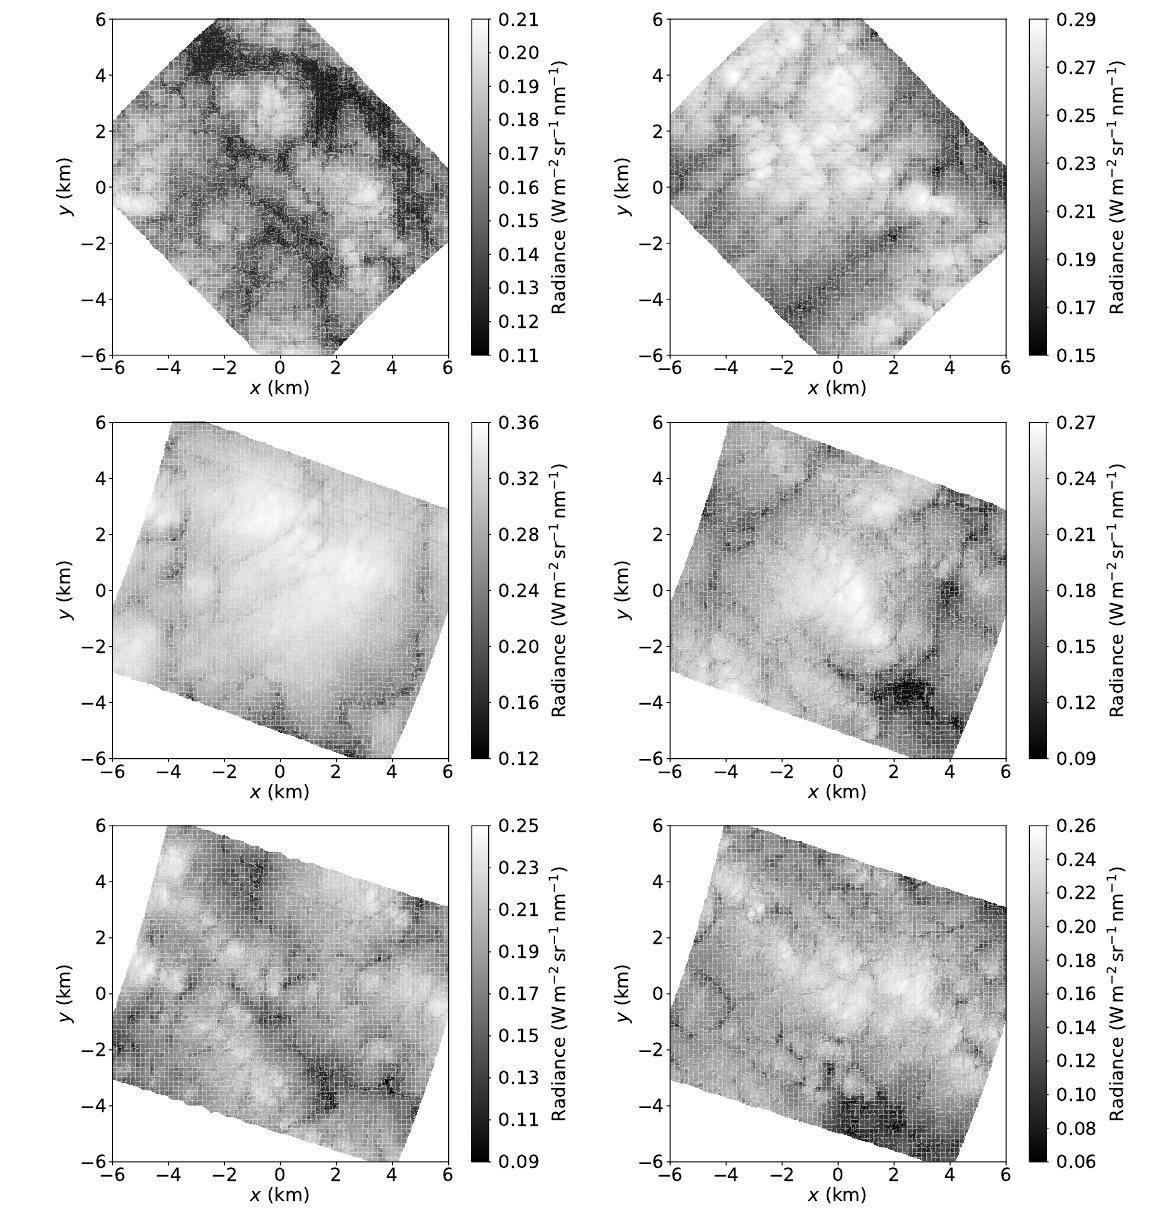
Figure 1. Radiance fields from six observed stratocumulus scenes during the ORACLES campaign. All images are nadir views of the 450 nm band aquired by the Airborne Multiangle SpectroPolarimetric Imager (AirMSPI) on 22 September 2016 off the coast of Namibia. In spite of variation in cloud cover, the characteristic stratocumulus structure composed of cellular blobs and thin spiderweb-like slits is